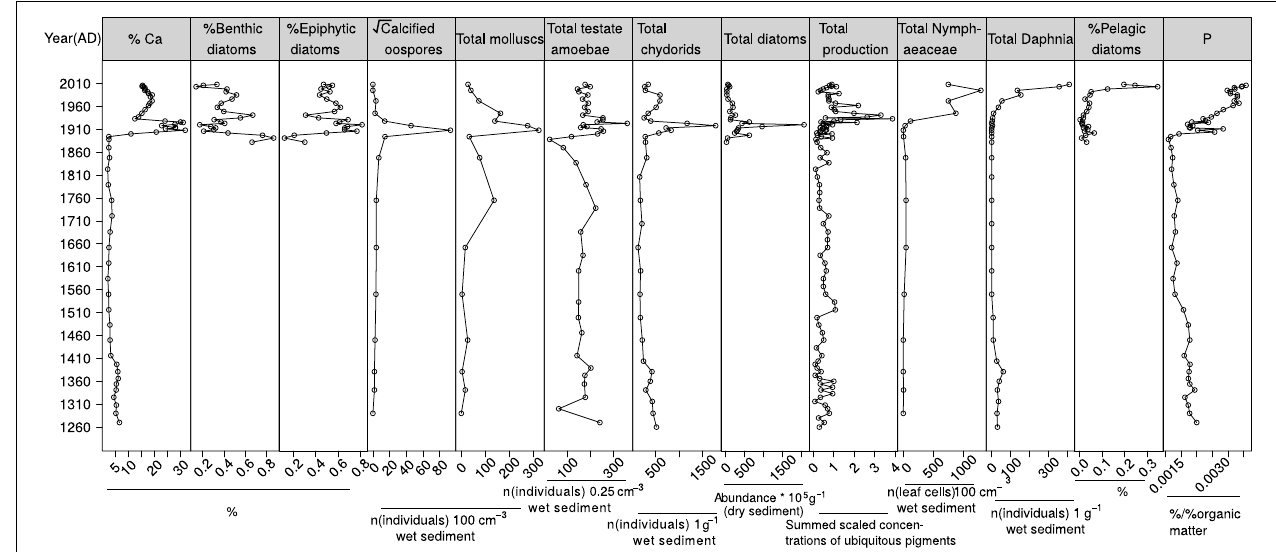
FIGURE 4 | Summary plot of CUNS2 Ca, P, and key absolute and relative abundance changes of biological groups against time.